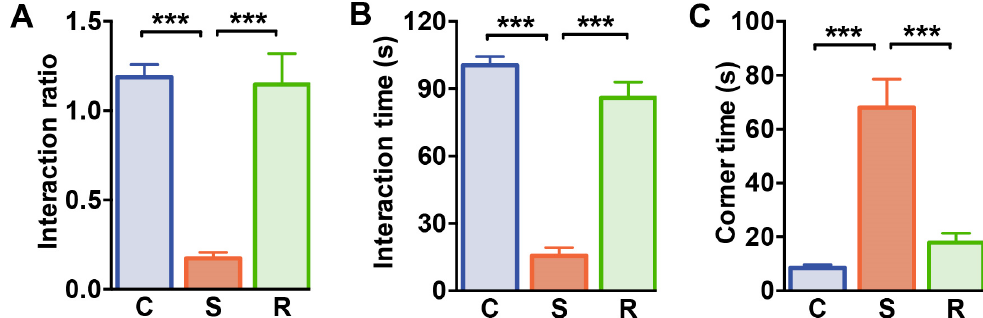
Figure 1. Social interaction test. ( A ) Interaction ratio, ( B ) the time spent in the interaction zone during the social interaction trial, and ( C ) the time spent in the corners on the opposite site of the interaction enclosure. Bar graphs represent mean + SEM. C: control, S: susceptible, R: resilient. n C = 15, n S = 16, n R = 11. ***: p < 0.001 (Bonferroni post = 11. ***: p < 0.001 (Bonferroni post hoc). n R